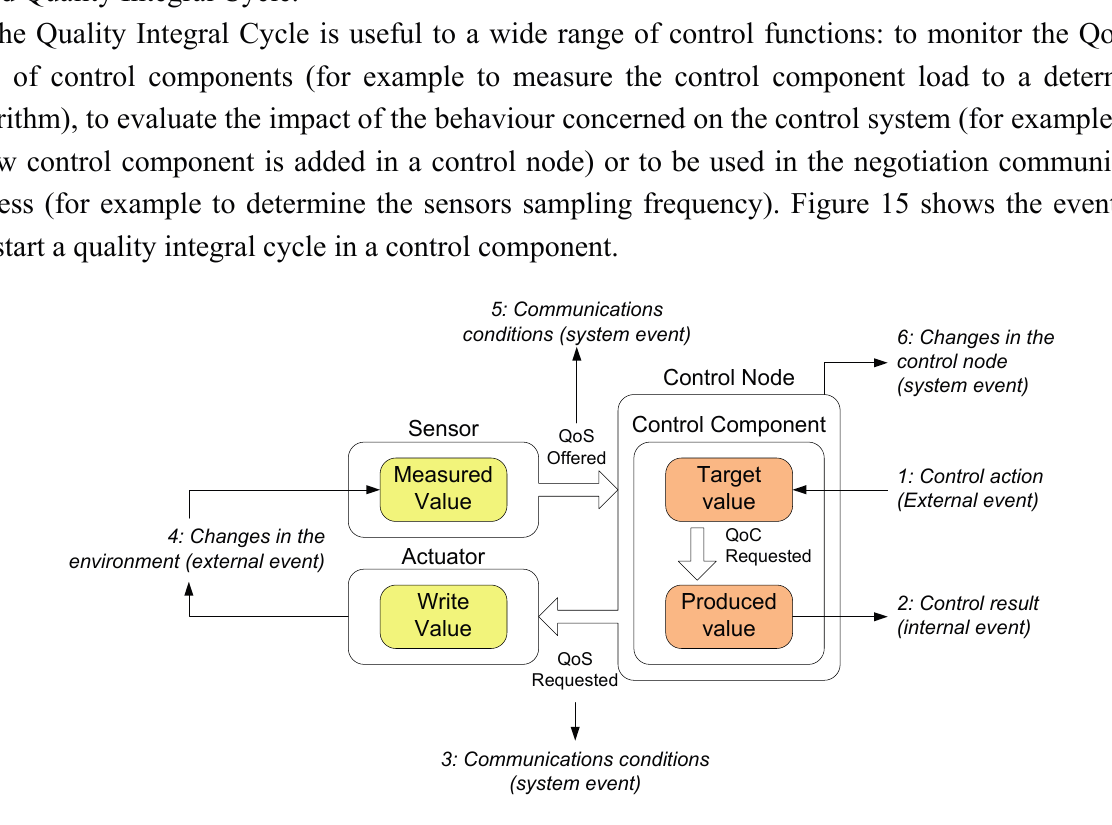
Figure 15. Quality Integral Cycle, QoS and QoC used and events that start the